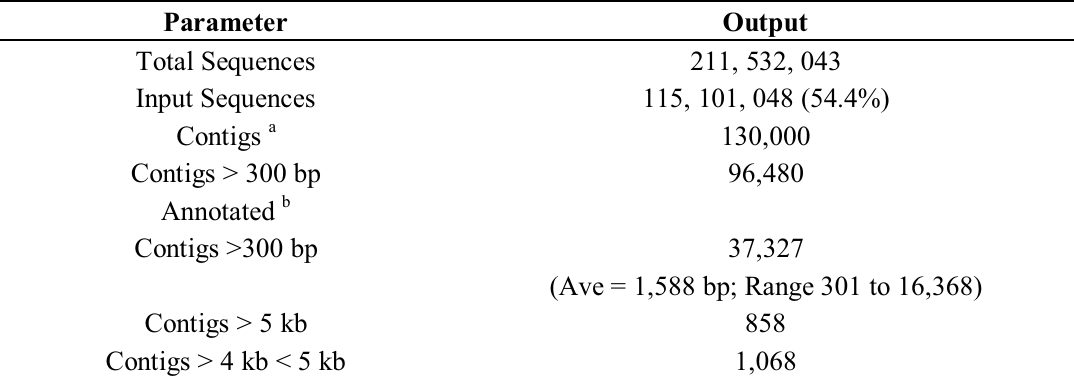
Table 1. Assembly and Annotation Summary of Illumina sequence Tags Derived from Immune-Stimulated Adult and Nymphal Anasa tristis